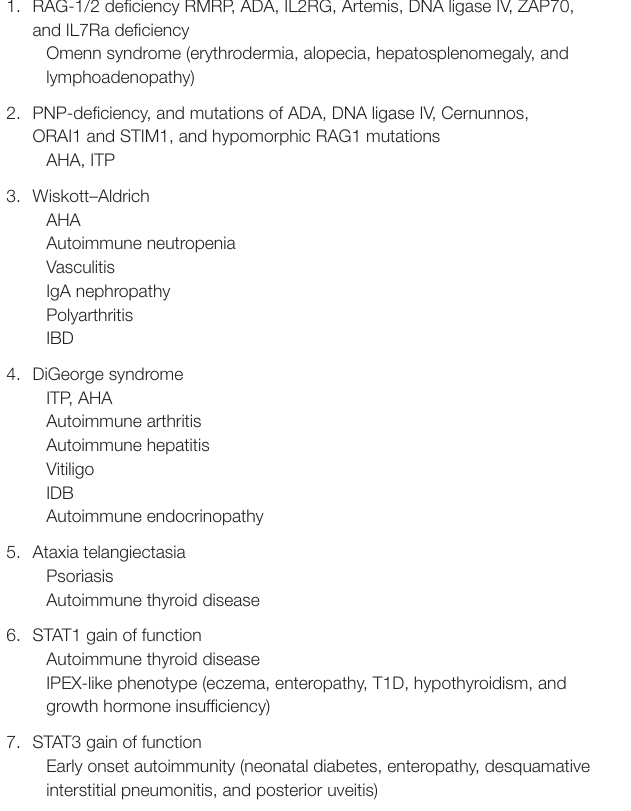
TABLe 2 | Autoimmune manifestations in combined immunodeficiencies and in syndromes with